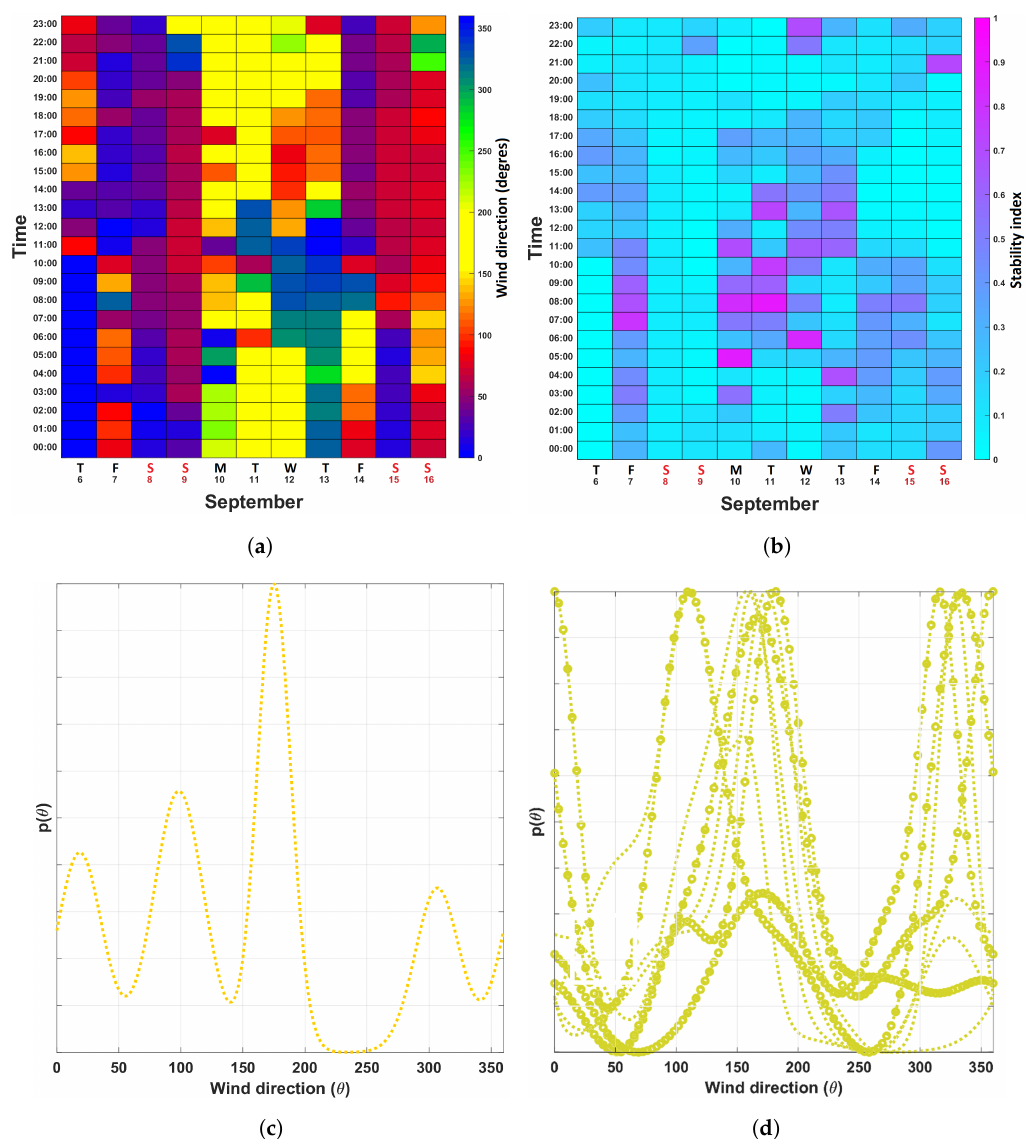
Figure 9. Ventilation calendars for location S-3. ( a ) Wind direction calendar. ( b ) Turbulence calendar. ( c ) Global mvM ( θ ) calendar. ( d ) Hourly distributions mvM ( θ ) computed with data collected during the morning of September 10th and September 11th,